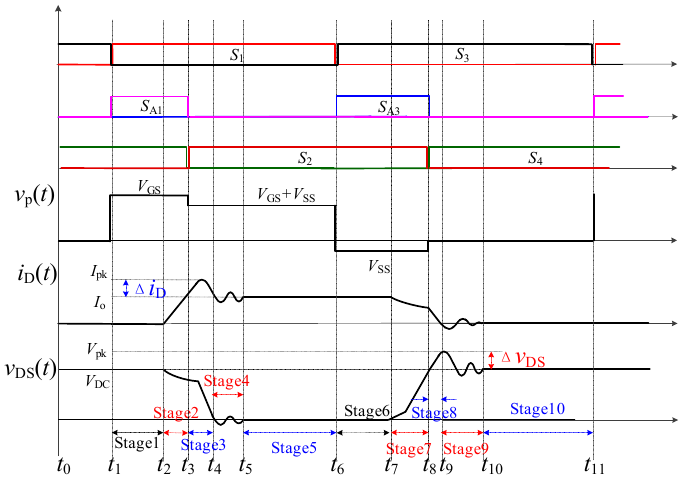
Figure 5. Switching waveforms based on the proposed gate driver.